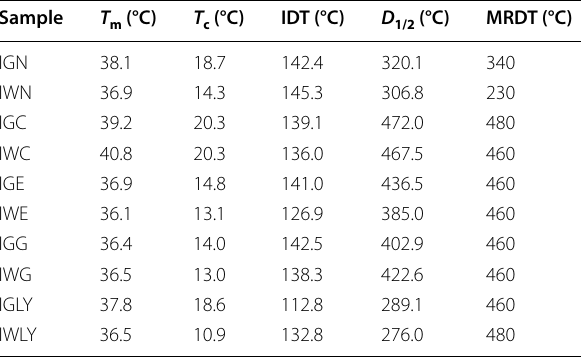
Table 4 Thermo-physical properties of the Irvingia adhesive samples as determined by DSC and b TGA